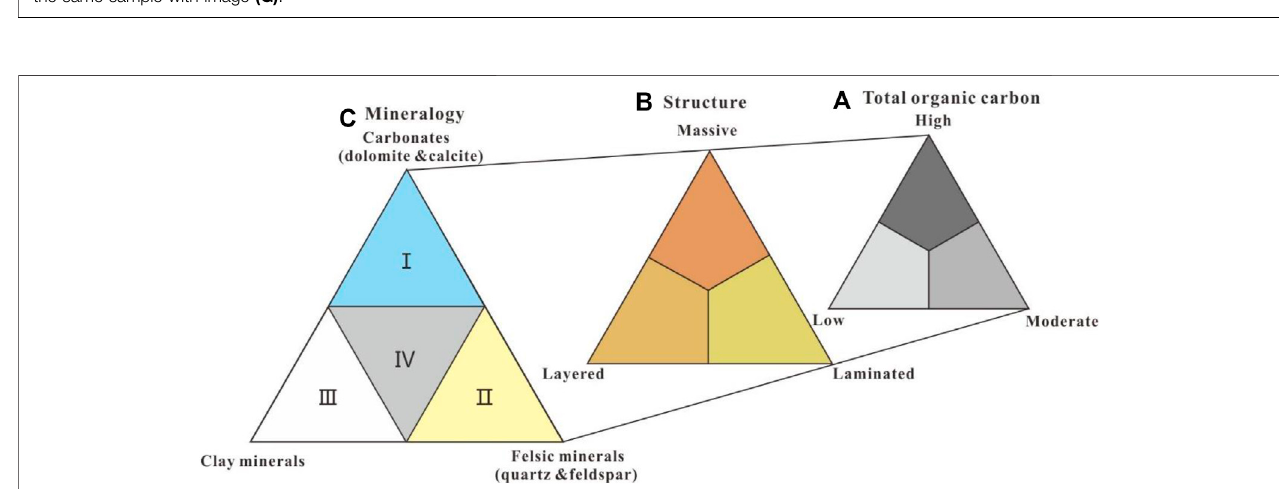
FIGURE7| Classi fi cationofshalelithofaciesusing (A) contentoftotalorganiccarbon(rich,morethan3 wt.%;moderate,1 – 3 wt.%;low,lessthan1 wt.%(modi fi ed from Allix et al., 2010; Liu et al., 2019), (B) structure types, and (C) mineral composition. I: calcareous shale; II: argillaceous marlstone; III: siliceous shale.